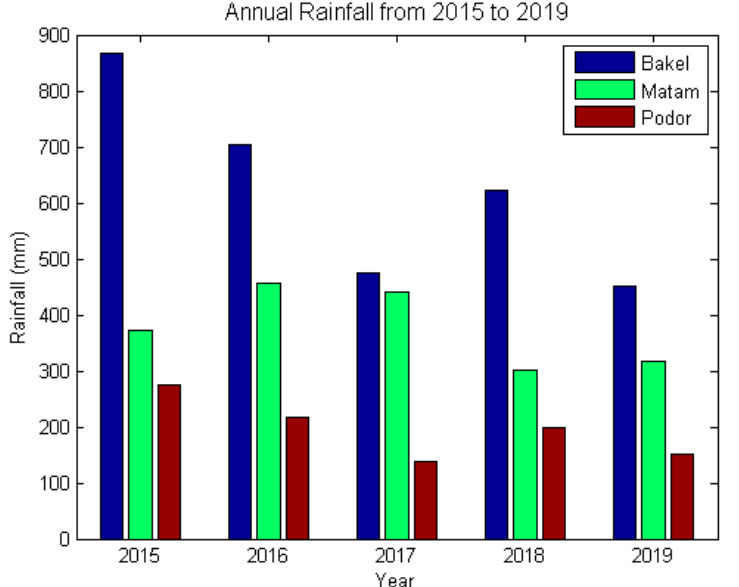
Figure 6. Annual rainfall in Bakel, Matam and Podor (2015–2019). Data source: Agence Nationale de l’Aviation Civile et de la Météorologie (ANACIM).